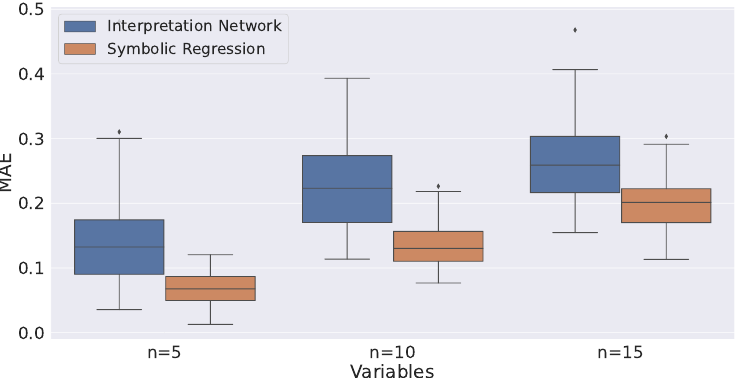
Figure 5. Runtime evaluation. The plot shows a comparison of the average time (in milliseconds) required for explaining a single neural network for symbolic regression and the I -Net on a logarith- mic scale.